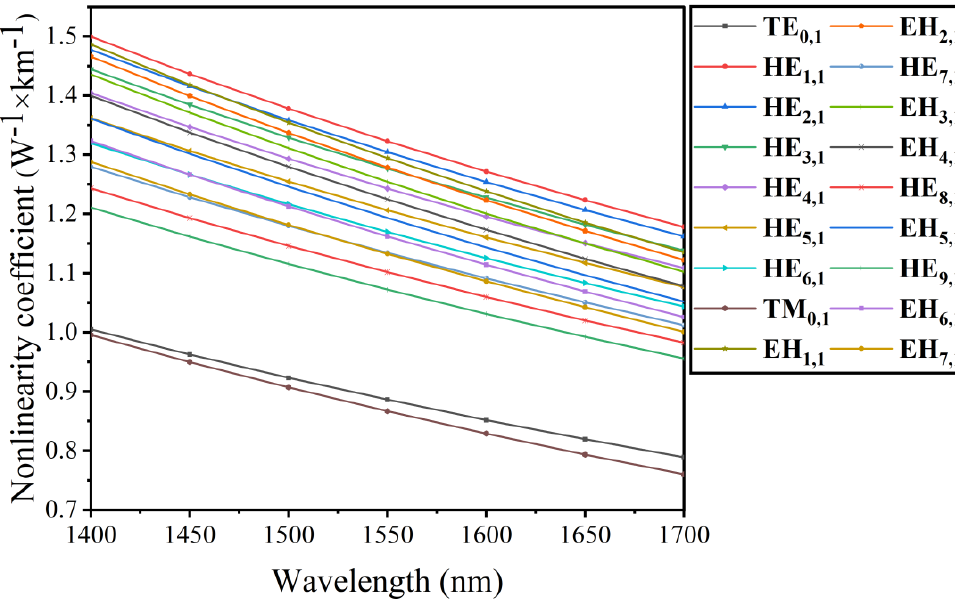
Figure 12. The relation between NC and wavelength in different vector modes.